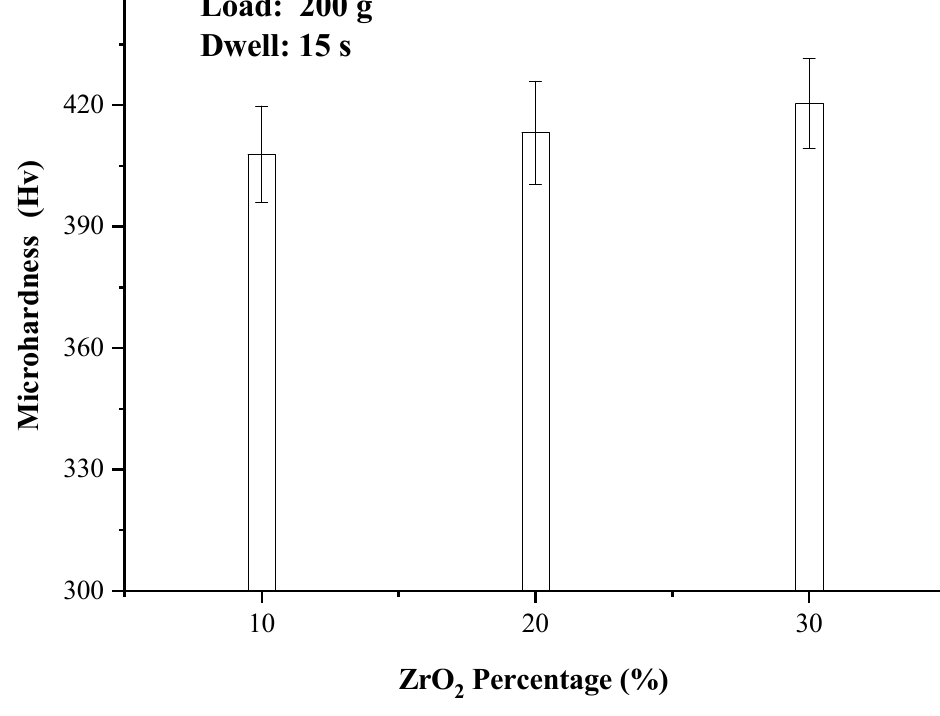
Figure 9. Microhardness of different ZrO 2 compositions.